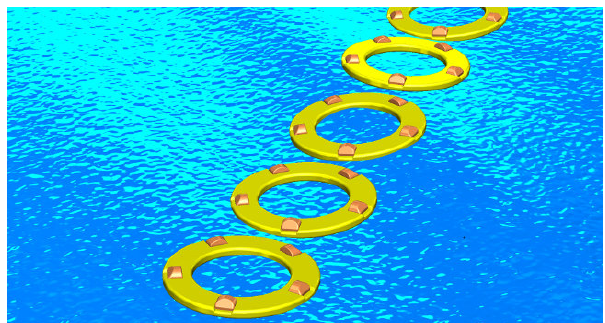
Figure 8. Artistic impression of array based on